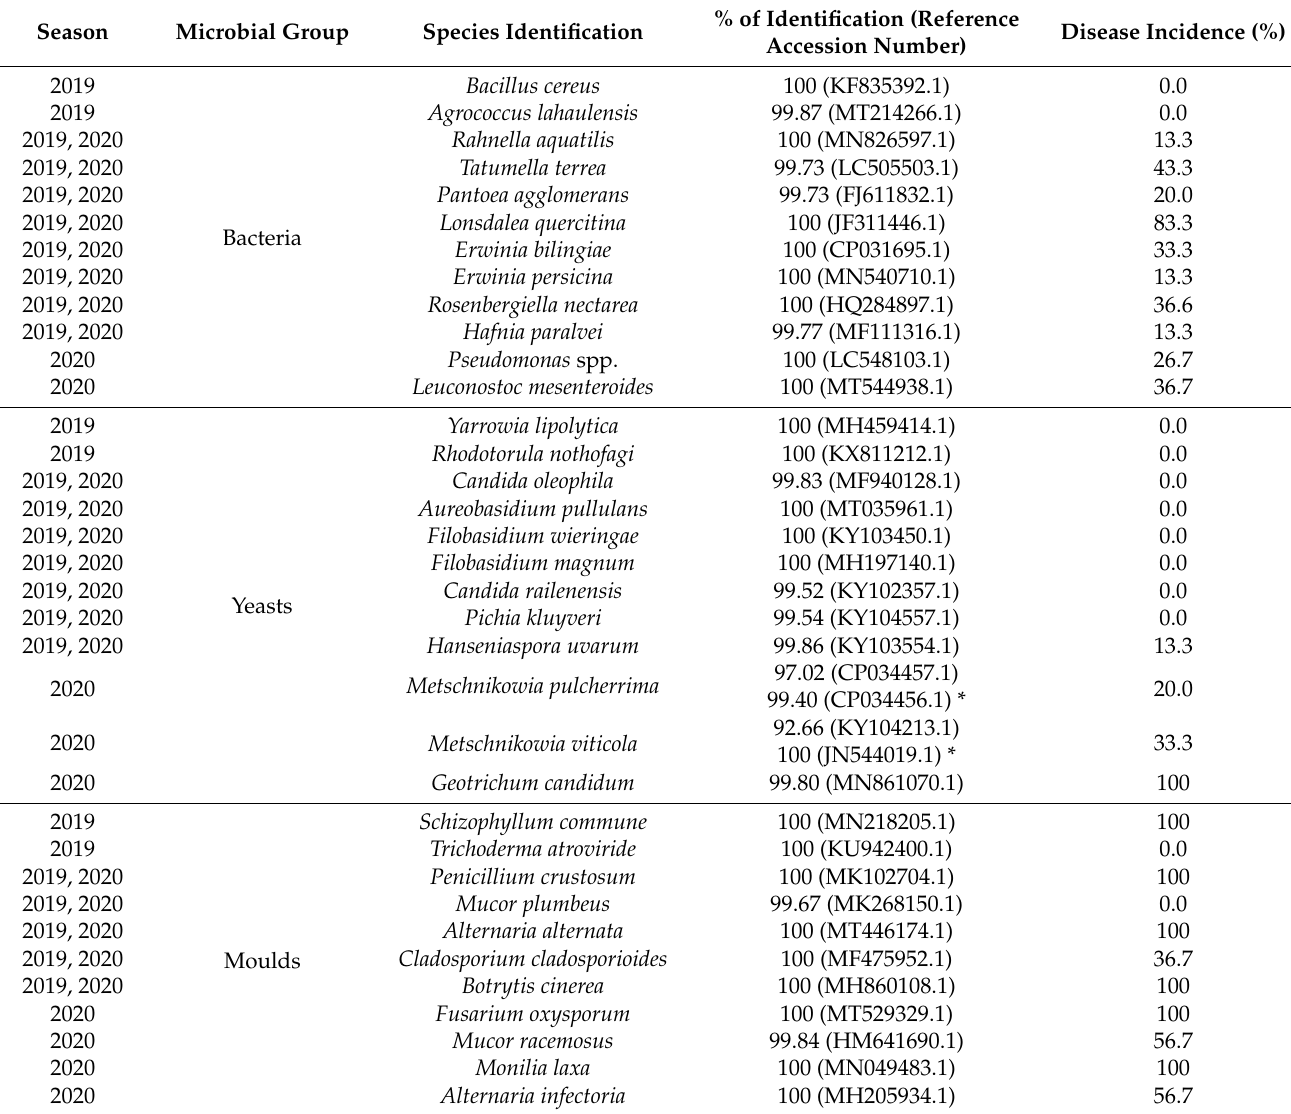
Table 1. Microbial identification of bacteria, yeasts, and moulds isolated in 2019 and 2020 from cherries with ‘aqueous spot’ symptoms, and disease incidence of each